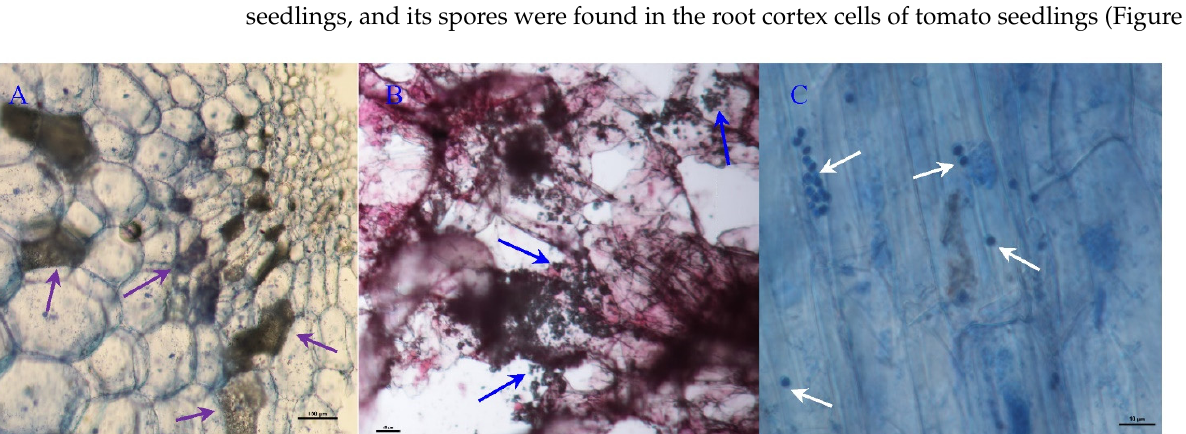
Figure 1. Infection of A. caulinodans in tomato stems ( A ) and roots ( B ), and infection of P. indica in tomato roots ( C ). In panel A, the arrows indicate A. caulinodans located in intercellular space in tomato stems, stained with trypan blue; bar = 100 μ m. In panel B, the arrows indicate A. caulinodans located in the cortex intercellular space in tomato roots, stained with Gram staining solution; bar = 20 μ m. In panel C, the arrows indicate spores of P. indica stained with trypan blue; bar = 10 μ m.